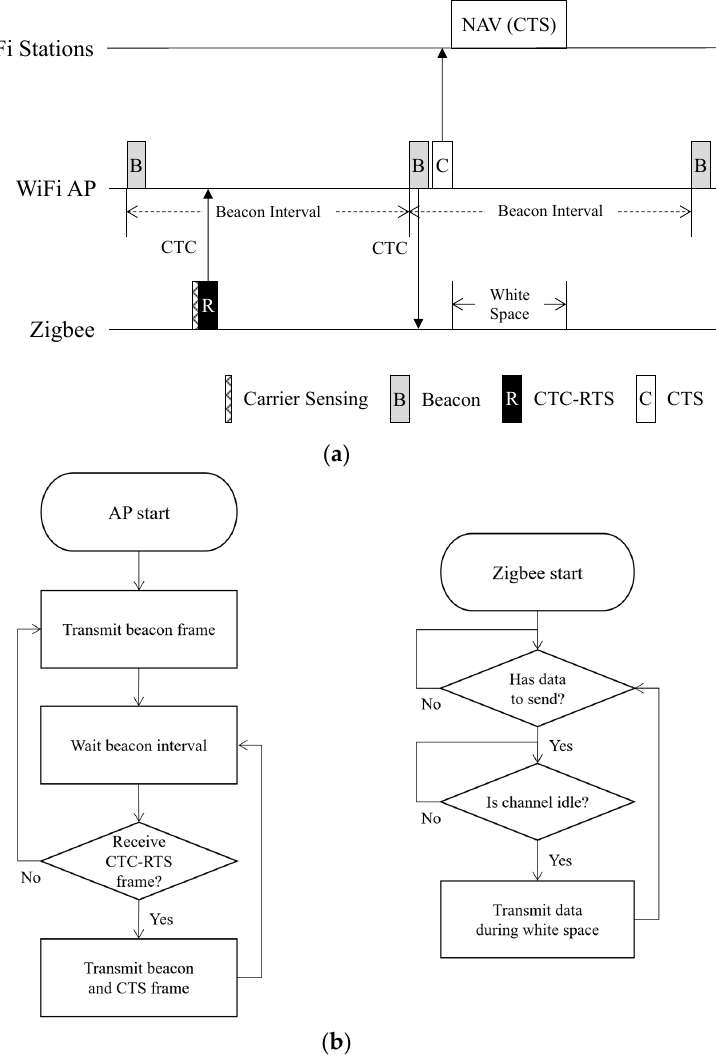
Figure 1. Overview of CTC − CSMA/CA Process. ( a ) Basic operation of CTC − CSMA/CA, ( b ) Flowchart of CTC − CSMA/CA.